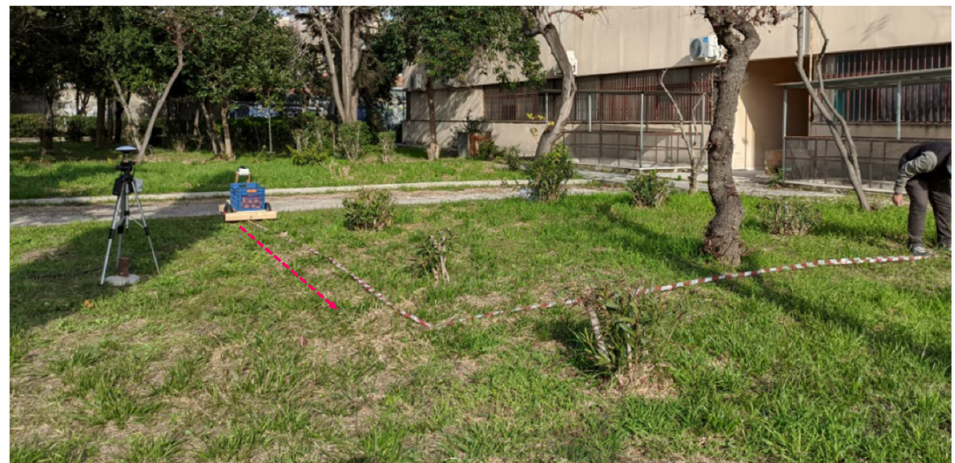
Figure 9. The experimental arrangement deployment being necessary for testing the path-following accuracy of the proposed robotic vehicle on both smooth and comparatively rough terrains.